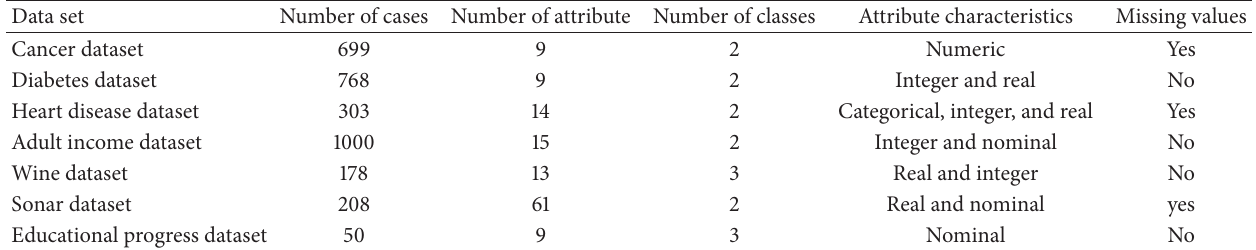
Table 4: Data set details.